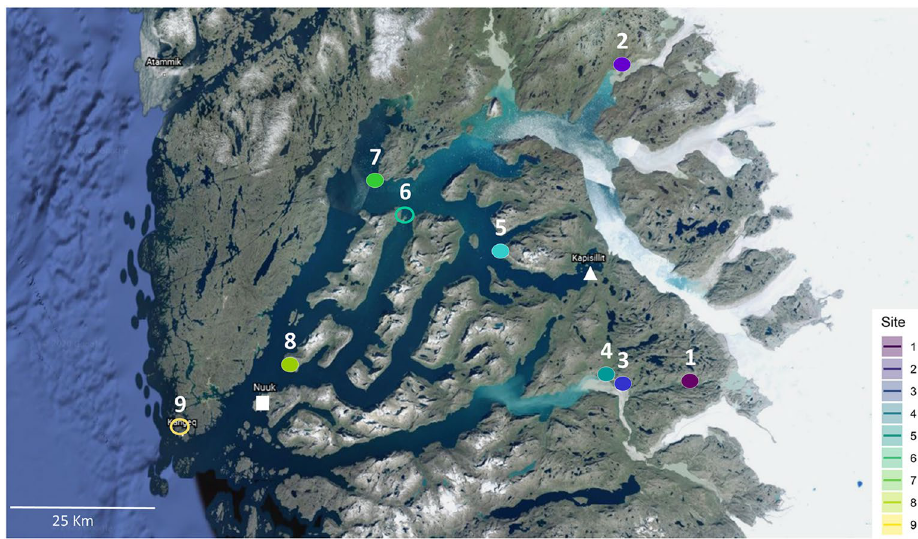
Figure 1. Locations of the study sites in the Nuuk Fjord region in Southwest Greenland. The ice to sea gradient is identified along an East–West transect from the inner fjord to the outer coast. The study sites are: 1: Austmannadal-2 (V53d), 2: Anavik (Ujarassuit), 3: Austmannadal-1 (V52a), 4: Sandnes (Kilaarsarfik), 5: Iffiartarfik, 6: Qoornoq, 7: Nuugaarsuk, 8: Ersaa and 9: Kangeq. The capital Nuuk and the village Kapisillit are identified by a white full square and triangle respectively. Colours (from dark to light) refer to the ice to sea gradient. Filled circles represent sites characterized by past anthropogenic nutrient enrichment (PANE) and control (CONT) samples while empty circles are characterized by PANE only. Figure 1 was generated by Angela Luisa Prendin in Inkscape v1.0.1 (https:// inksc ape. org/) and it is based on the Nuuk fjord map obtained with Google Earth Pro v7.3 (https:// earth. google.